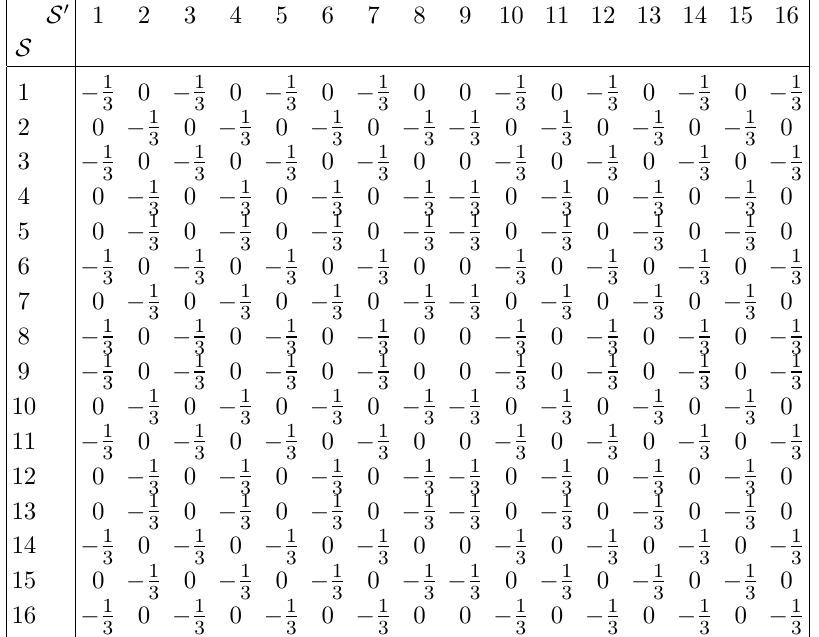
Table 24 . Gadget values for P